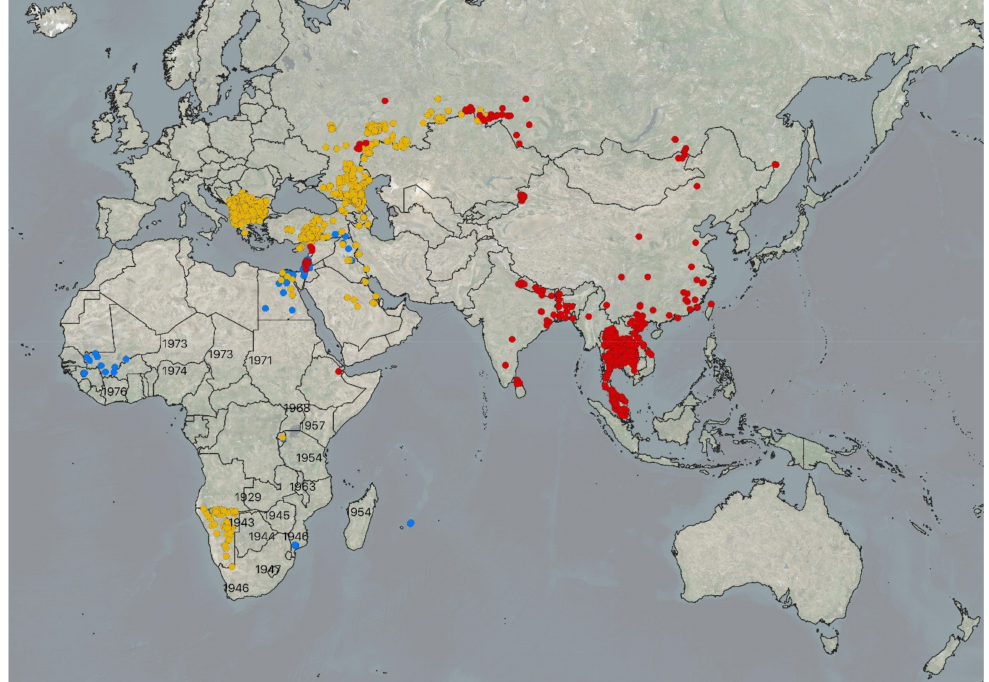
Figure 1. Geographical extent of lumpy skin disease outbreaks reported to EMPRES Global Animal Disease Information System of the Food and Agriculture Organization (https://empres-i.review.fao.org/#/, last accessed 23 September 2021) between January 2006 and May 2021. Outbreaks marked with blue dots were reported in 2006–2013, yellow in 2014–2018, and red in 2019–2021. LSD is endemic across the African continent, except in Algeria, Morocco, Libya, and Tunisia. Historical data from Africa were taken from Woods (1990) [8]. Black numbers indicate the year of the first recorded LSD outbreaks in the respective